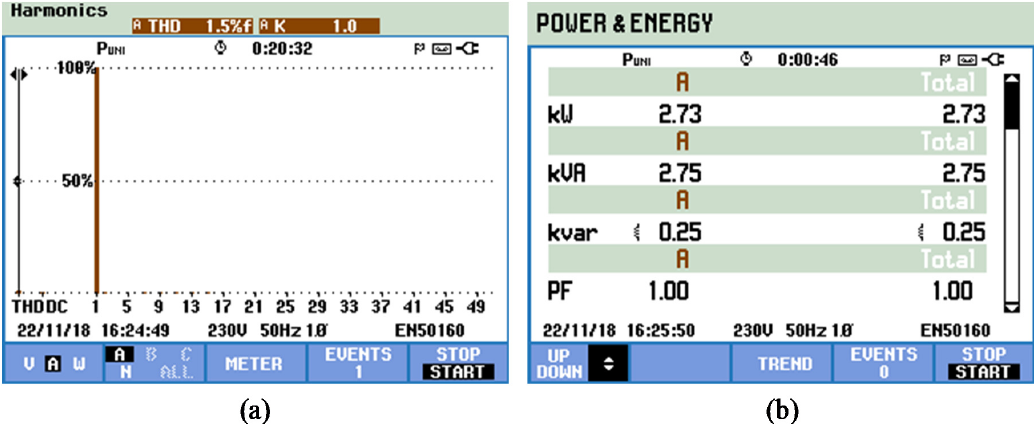
Figure 29. Experimental results during the MF-EVCS operation combined with the operation of an on-board EV charger (compensating current harmonics and power factor): ( a ) Harmonic spectrum of the total home current ( i g ); ( b ) Operating powers and total power factor.